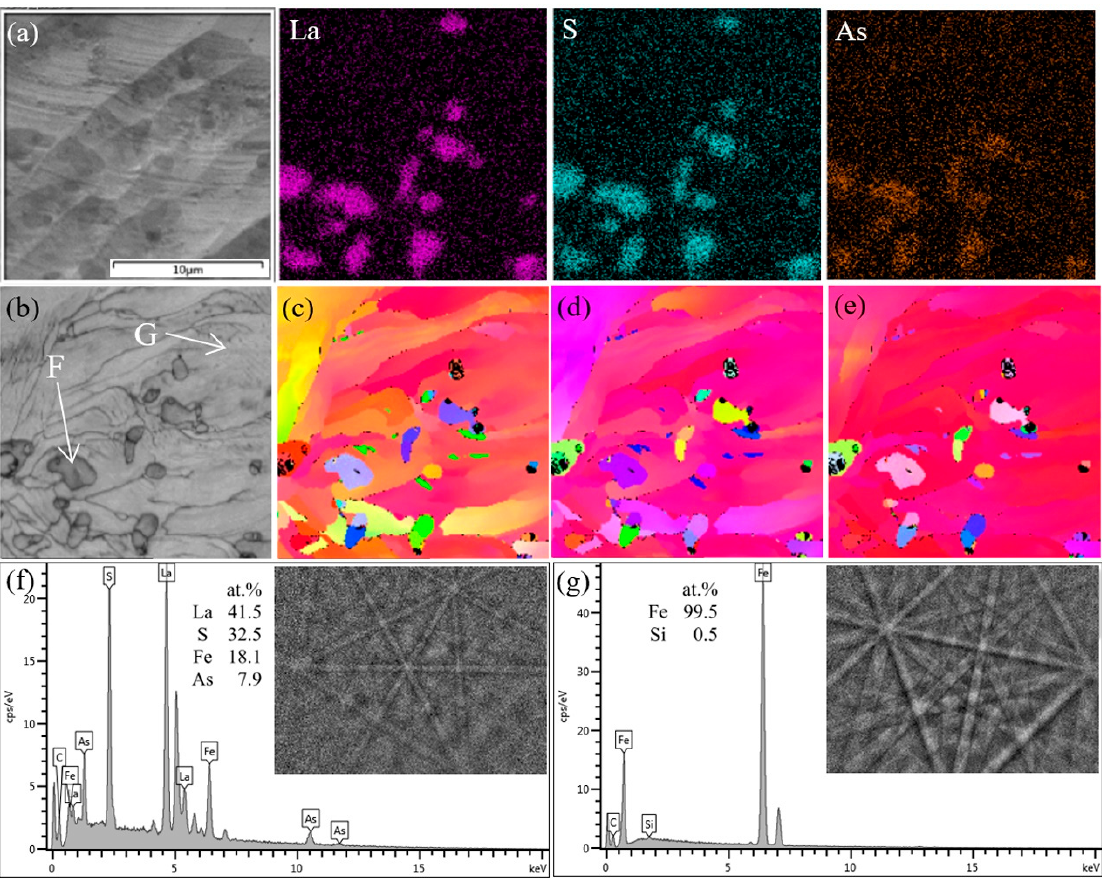
Figure 6. Morphologies, chemical compositions, and phase identification of La-S-As inclusions. ( a ) Morphologies of the argon ion polished sample; ( b ) contrast chart; ( c ) to ( e ) orientation in X, Y, Z directions; ( f ) EDS and EBSD patterns of L-S-As inclusions (point F); ( g ) EDS and EBSD patterns of the steel matrix (point G).